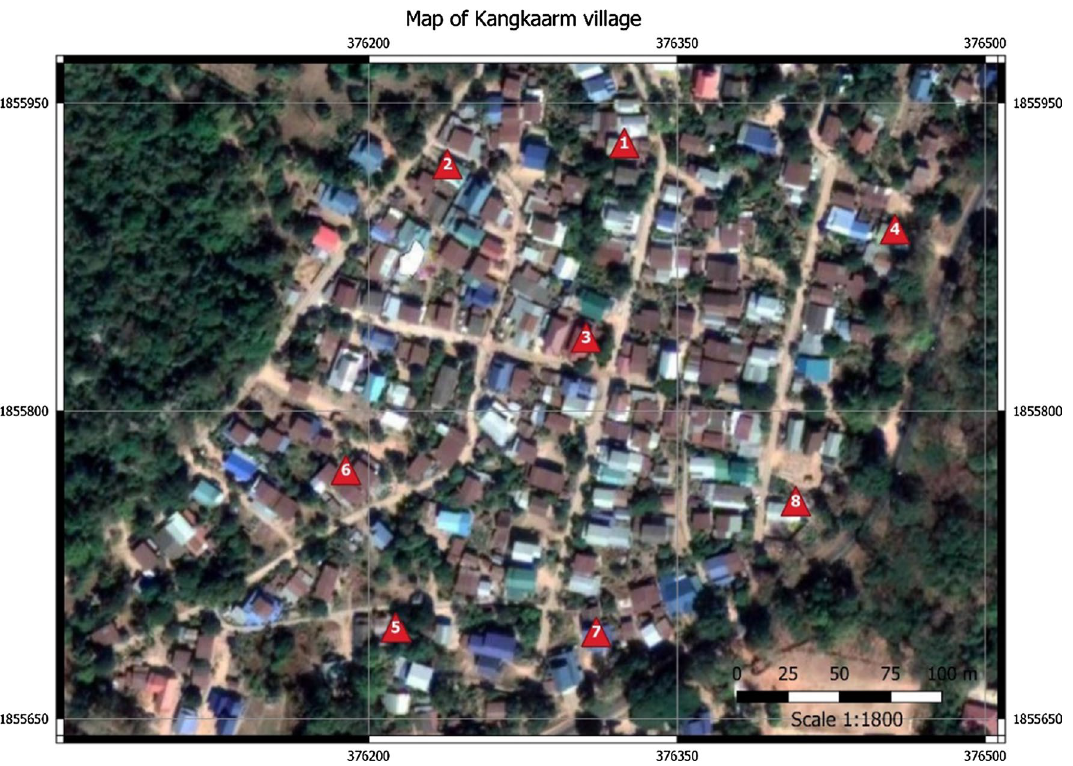
Fig. 3 Eight sampling stations at Kang Ka-am village in Somdet district, Kalasin,